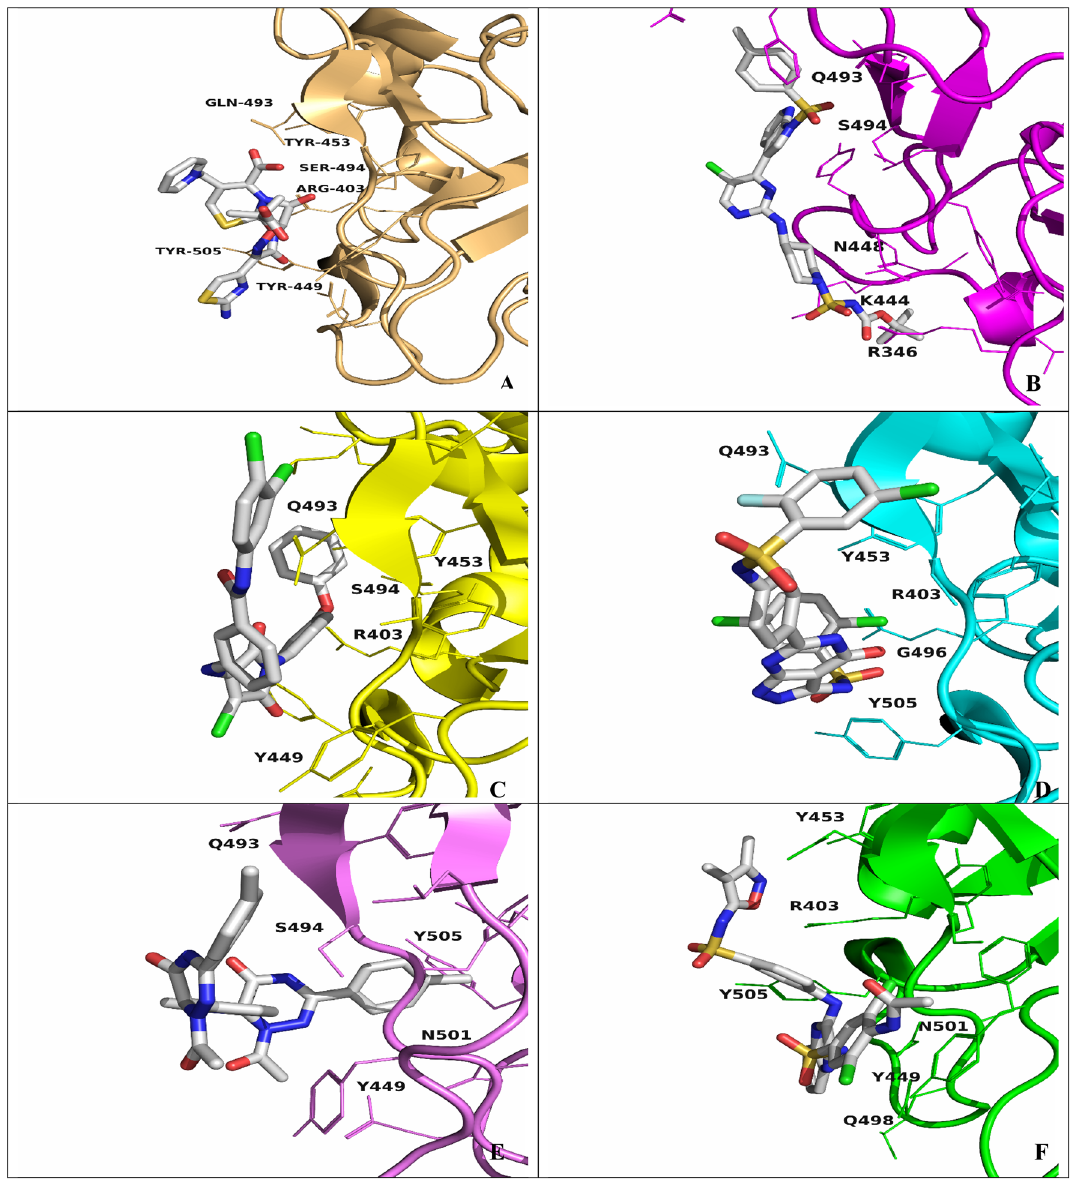
Figure 7. Docked positions of the ligand–protein complexes after MD simulations generated by extracting the last frame of the simulation. ( A ) Ceftazidime. ( B ) CID:1. ( C ) CID:2. ( D ) CID:3. ( E ) CID:4. ( F ) CID:5.